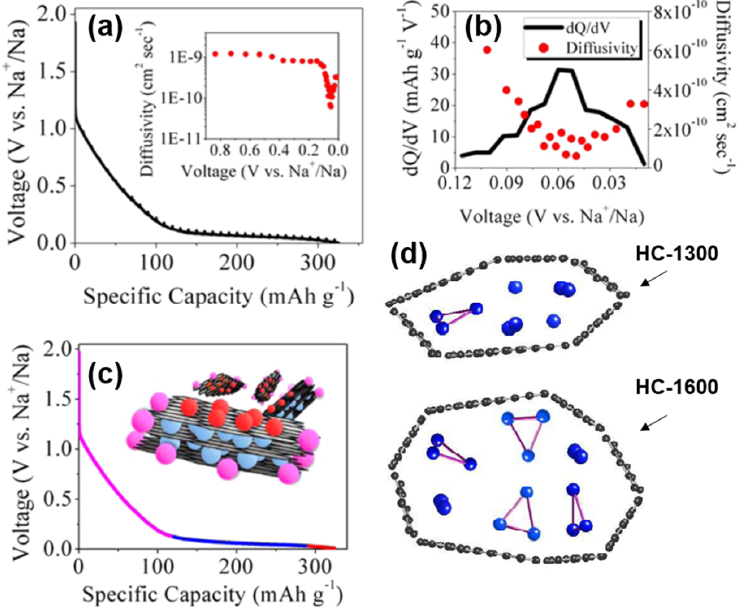
Figure 9. ( a ) GITT profile and diffusion coefficient as a function of states of charge (inset). ( b ) dQ/dV plot from 0.12 V to 0.01 V with corresponding diffusivity values within which a sudden small scale change can be observed. ( c ) Schematic of proposed Sodium-ion “adsorption-intercalation-pore filling” storage mechanism [69]. ( d ) Schematic models of sodium storage in HC nanopores of two different pyrolysis temperatures [71].